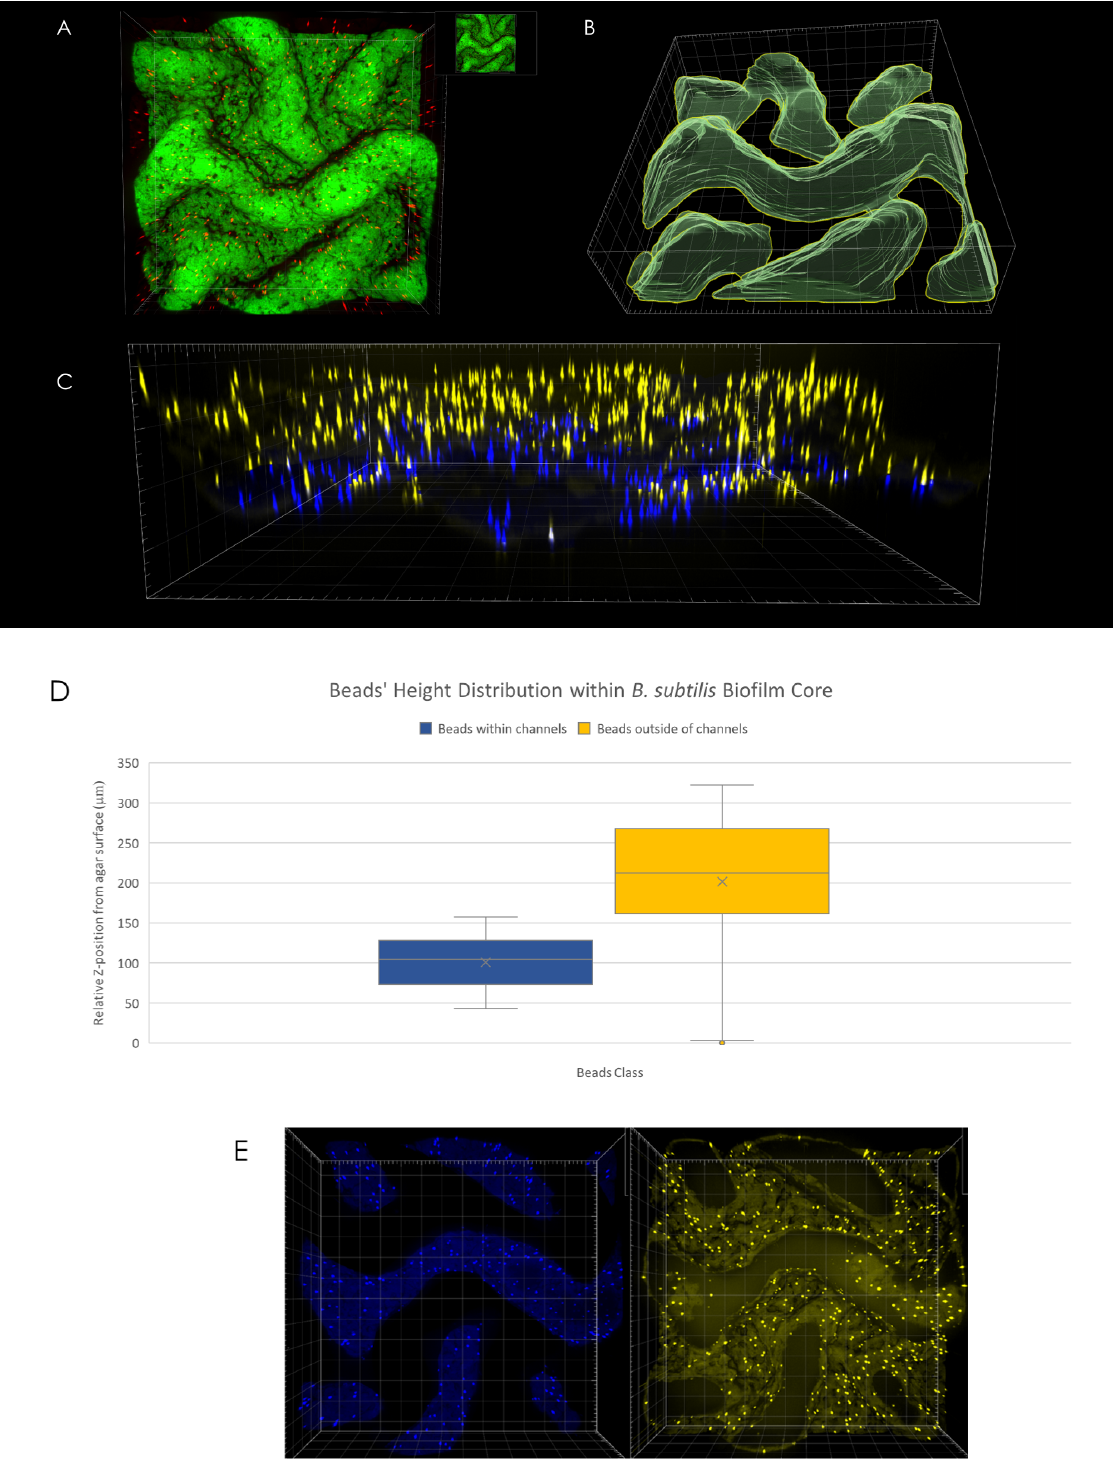
Figure 3. 3D microsphere distribution. ( A ) Top view of macrocolony center. ( B ) Channel interior surface render as visualized in Imaris software. ( C ) Side view of microspheres located within (blue) and outside of (yellow) channels’ interior. ( D ) Microspheres positional distribution in Z-axis. ( E ) Top view of microspheres within ( left ) and outside of ( right ) channels’